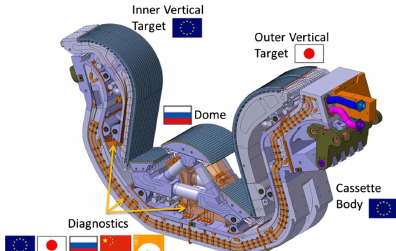
Figure 3. Parts of one of the 54 divertor modules. Reprinted with permission from Ref. [11]. Credit c (cid:13) ITER Organization, 2019.